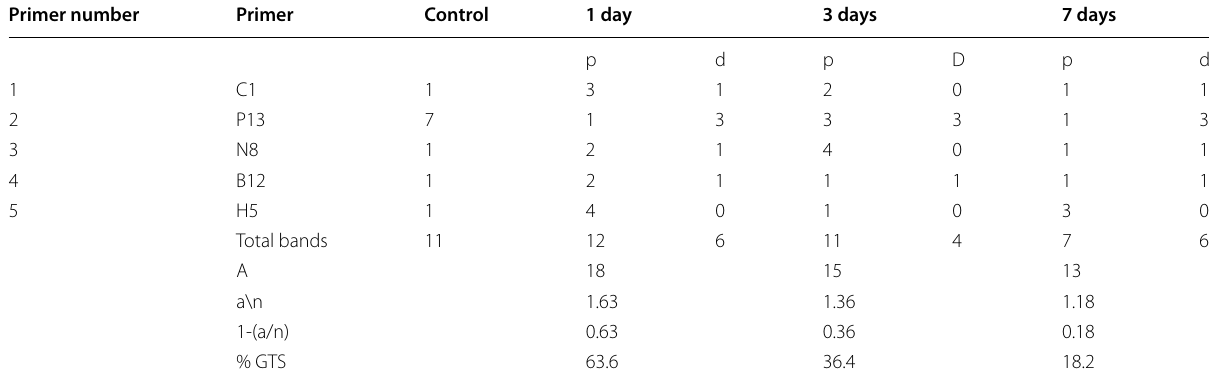
p is appearance band in treated sample, d is disappearance band in treated sample, a is polymorphic profile (a